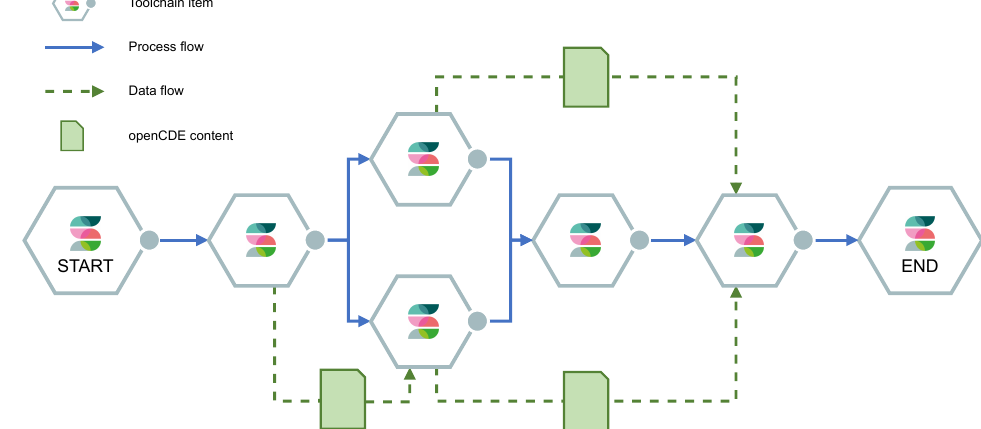
Figure 3. Conceptual representation of a BIMSWARM toolchain with contained activities, sequence flow, data flow, data objects, and start and end